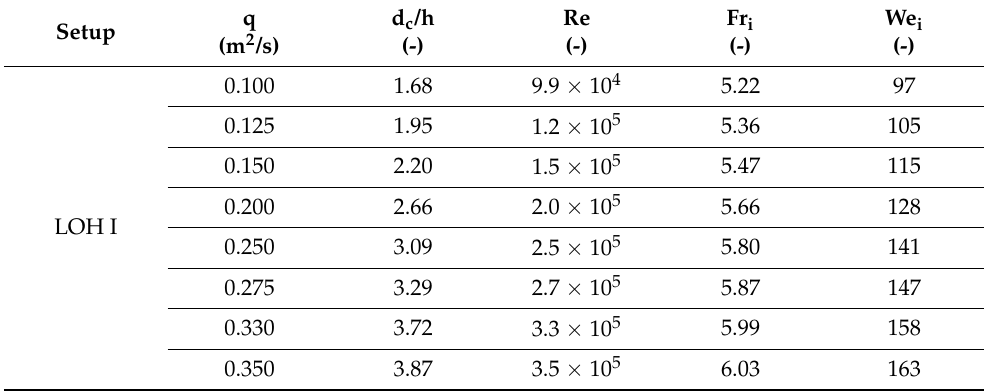
Figure 3. Sketch of the skimming flow on a steeply sloping stepped spillway and notation adopted to define the location of the pressure taps, as per [17–22]. Table 2. Test